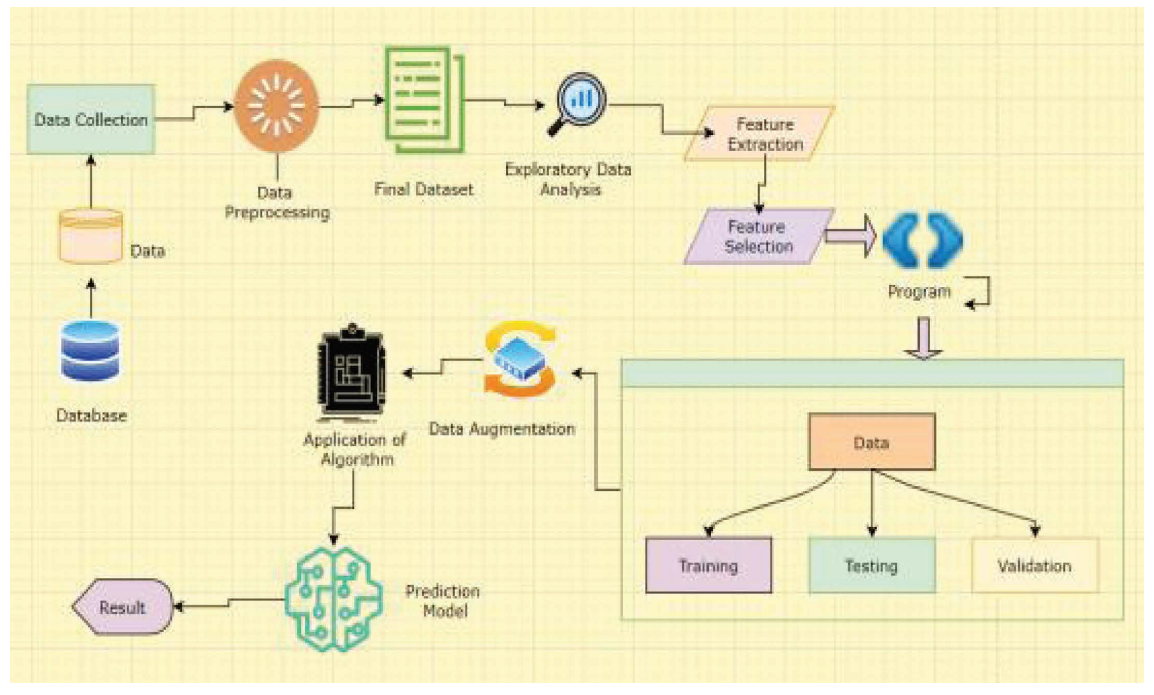
Figure 11: Architecture. Table 1: Comparison of all classifers.